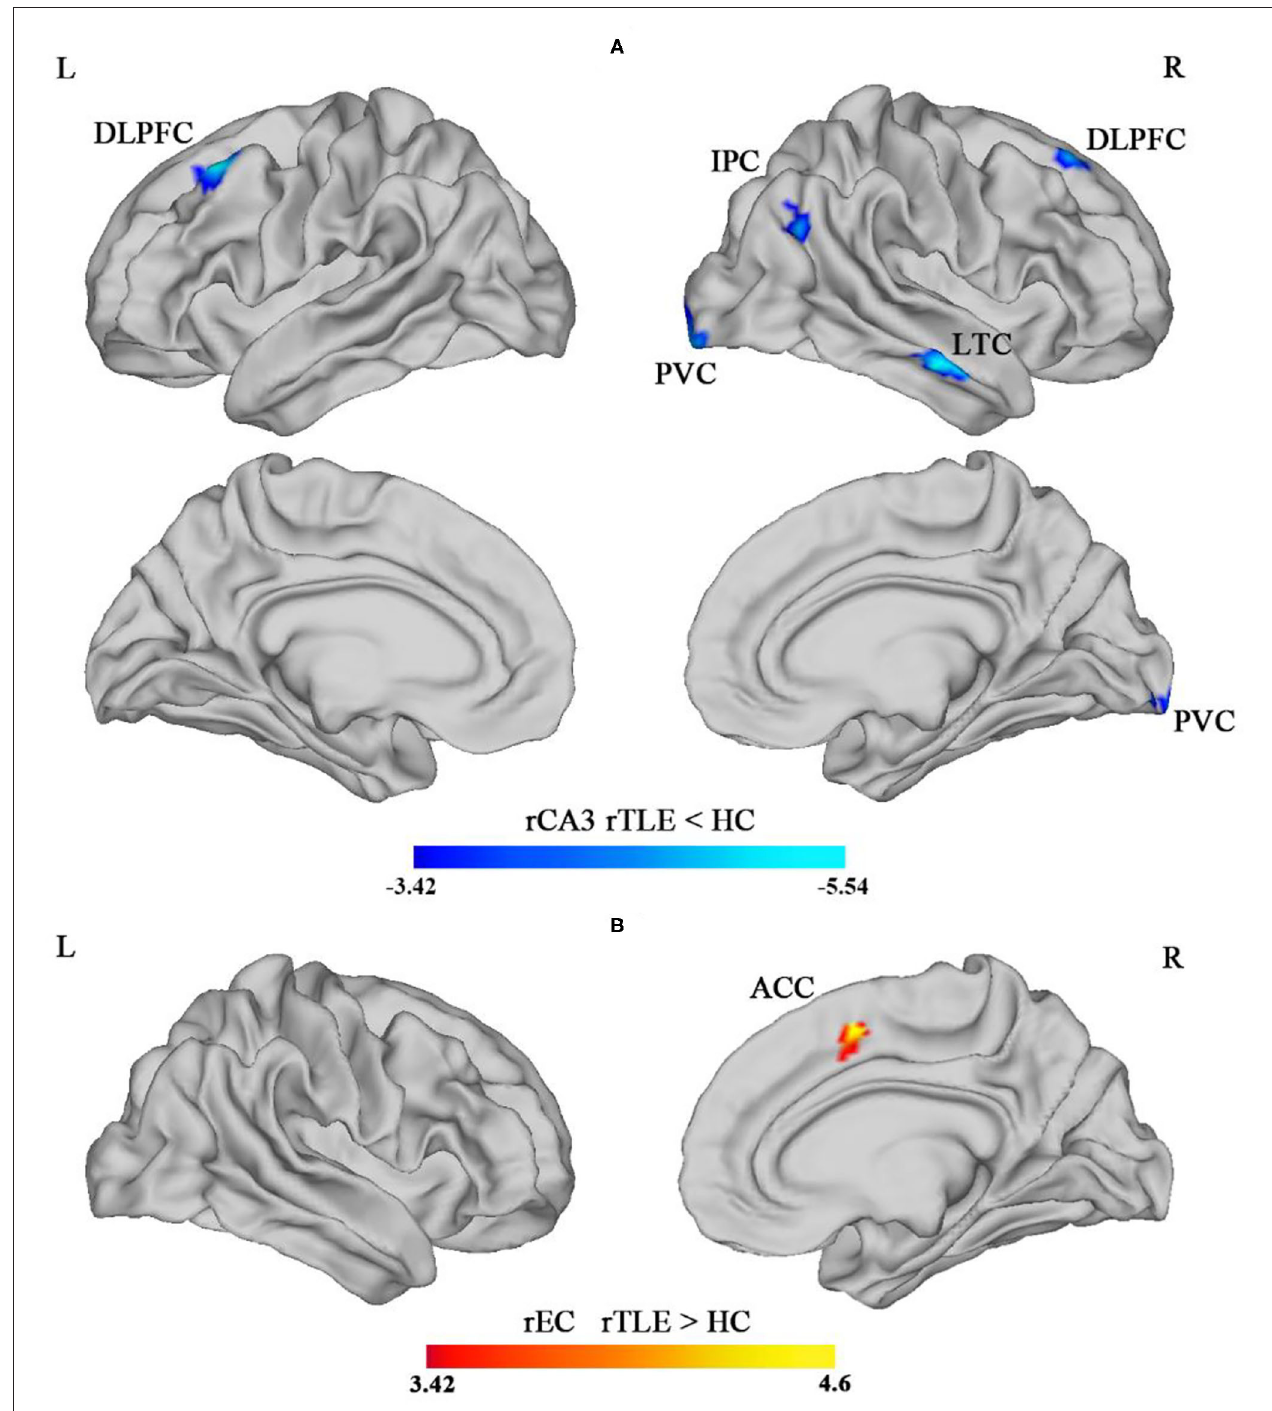
FIGURE 2 | Intergroup difference of the surface-based functional connectivity (SBFC) of the right CA3 (rCA3) in the hippocampal body. (A) The blue-colored region illustrates the decreased SBFC with the rCA3 in bilateral dorsolateral prefrontal cortex (DLPFC), right lateral temporal cortex (LTC), right inferior parietal cortex (IPC), and right posterior visual cortex (PVC), comparing rTLE and HC (rTLE < HCs). (B) The red-colored region illustrated the increased SBFC of the right entorhinal cortex (rEC) with the right anterior cingulate cortex (ACC) (rTLE > HCs) [ p < 0.05 ( p < 0.025 for each hemisphere), corrected by Monte Carlo